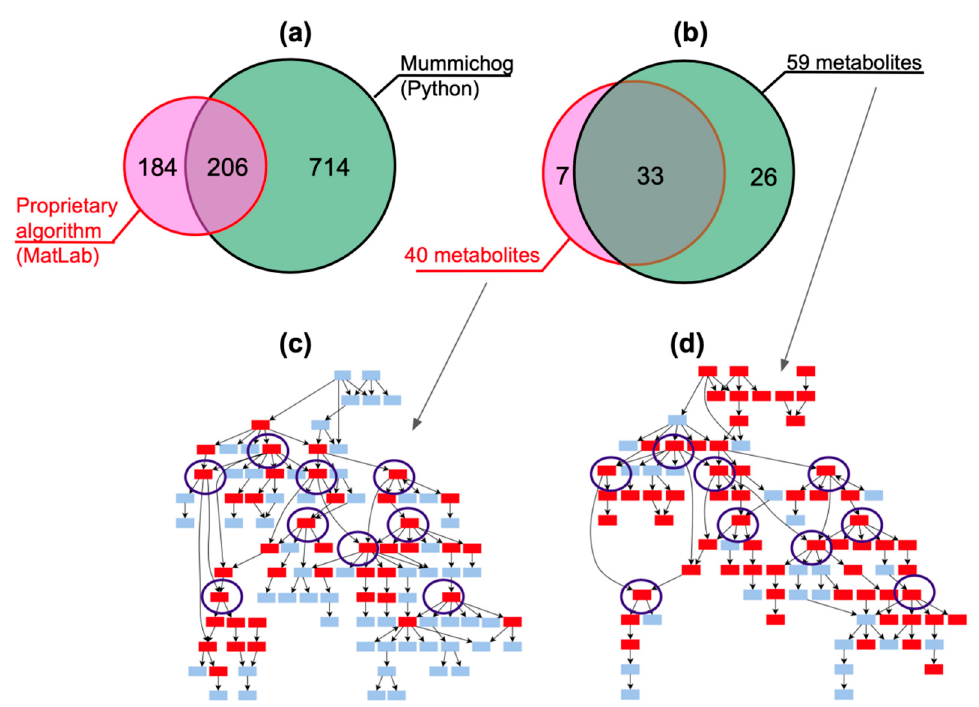
Figure 2. ( a ) KEGG-annotated metabolites related to the third stage of obesity (20 samples). The pink circle denotes the set of metabolites defined by the biological context, implemented in the MatLab development environment, followed by the application of the Wilcoxon test ( p -value < 0.01). The green circle represents the set of metabolites annotated with the Mummichog algorithm (MetaboAnalystR package). ( b ) Metabolites related to the synthesis of steroid hormones. The pink circle is the number of metabolites found by the algorithm based on the biological context (MatLab script), the green circle is the number of metabolites found by Mummichog. ( c , d ) Steroidogenesis pathways with the indication of annotated (red boxes) and non-annotated (blue boxes) metabolites. Outlined boxes with KeGG IDs are identical nodal metabolites found using two compared ap- proaches.